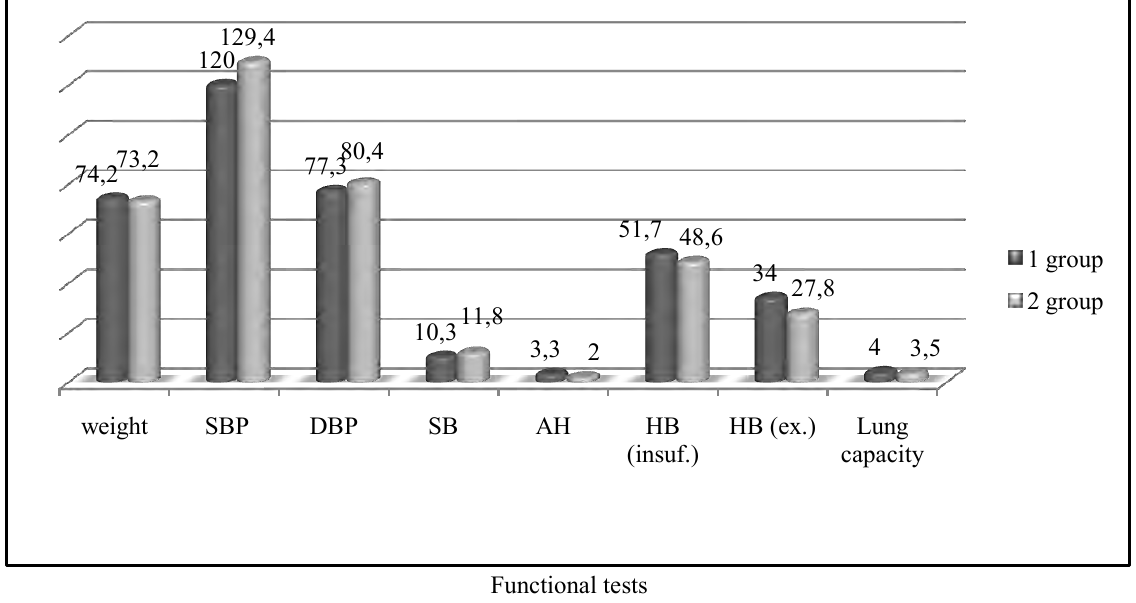
Fig.1 Results of measurements of functional potentials of 30-36 years old men